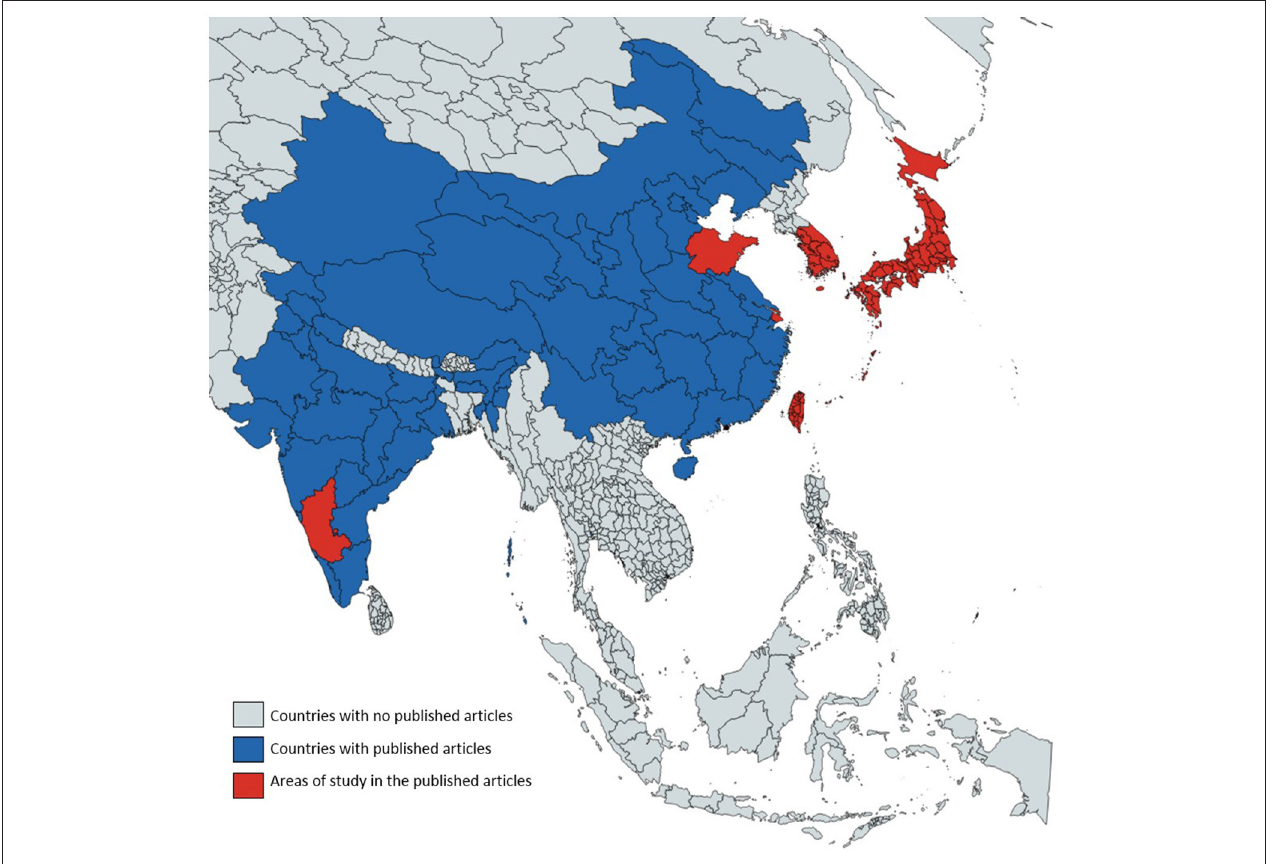
FIGURE 3 | Geographical areas with existing published estimates on MS